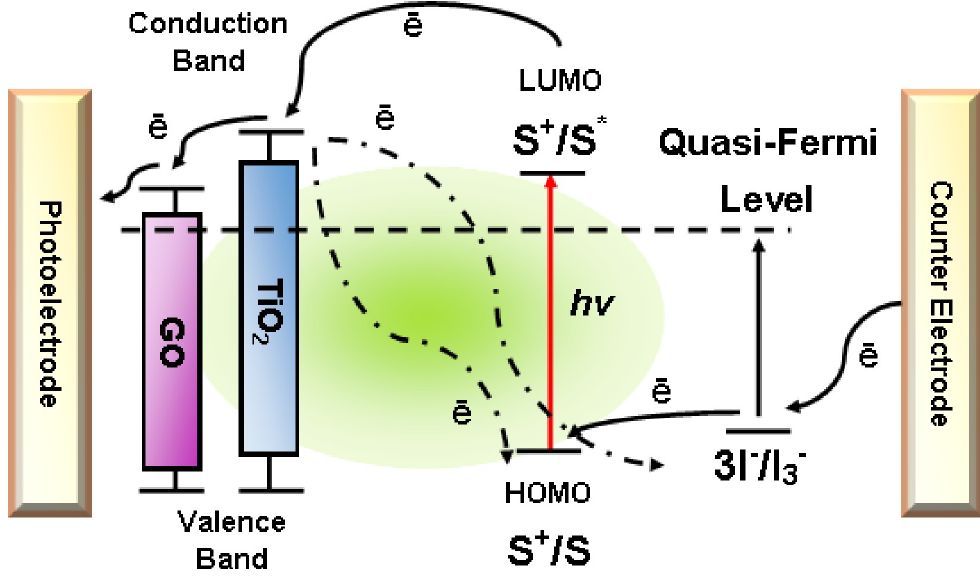
Fig 9. Working mechanism of